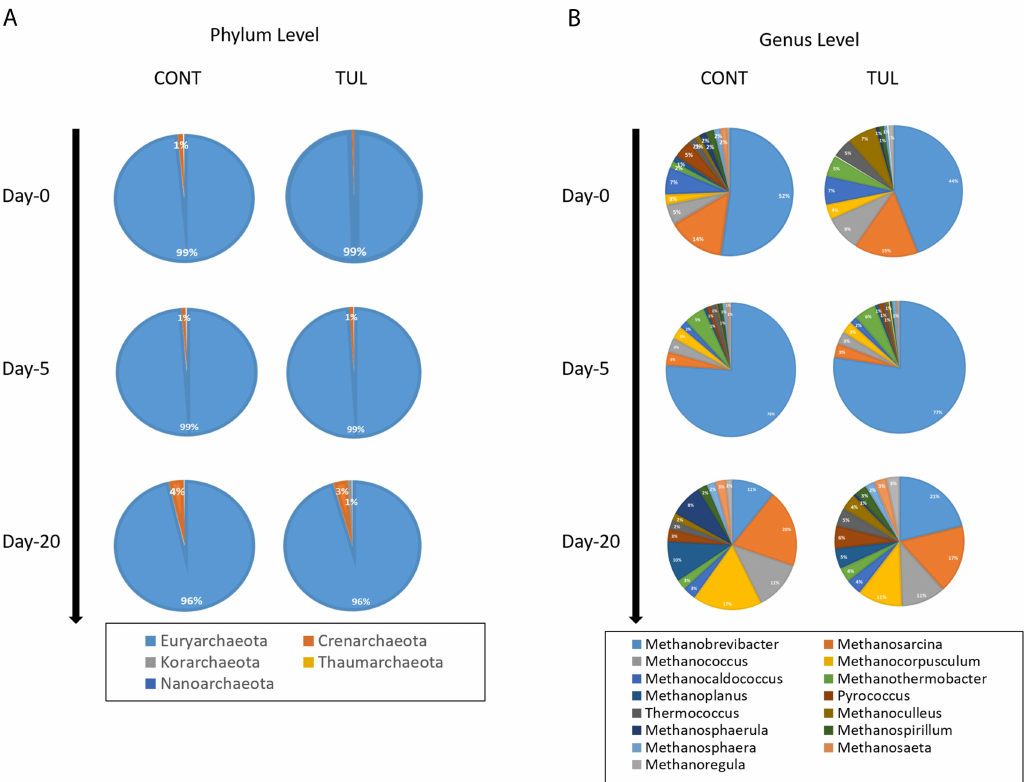
Figure 2. Fecal archaeome taxonomic classification of shotgun metagenomic sequences at the phylum ( A ) and genus ( B ) level for the control (CONT) and tulathromycin (TUL)-treated piglets at days 0, 5, and 20 of life. Only those bacterial phyla and genera that averaged more than 1% of the relative abundance across all samples are